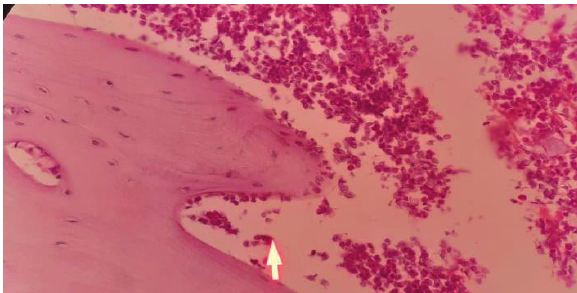
Fig-3 : Photomicrograph of ankle joint of Group B